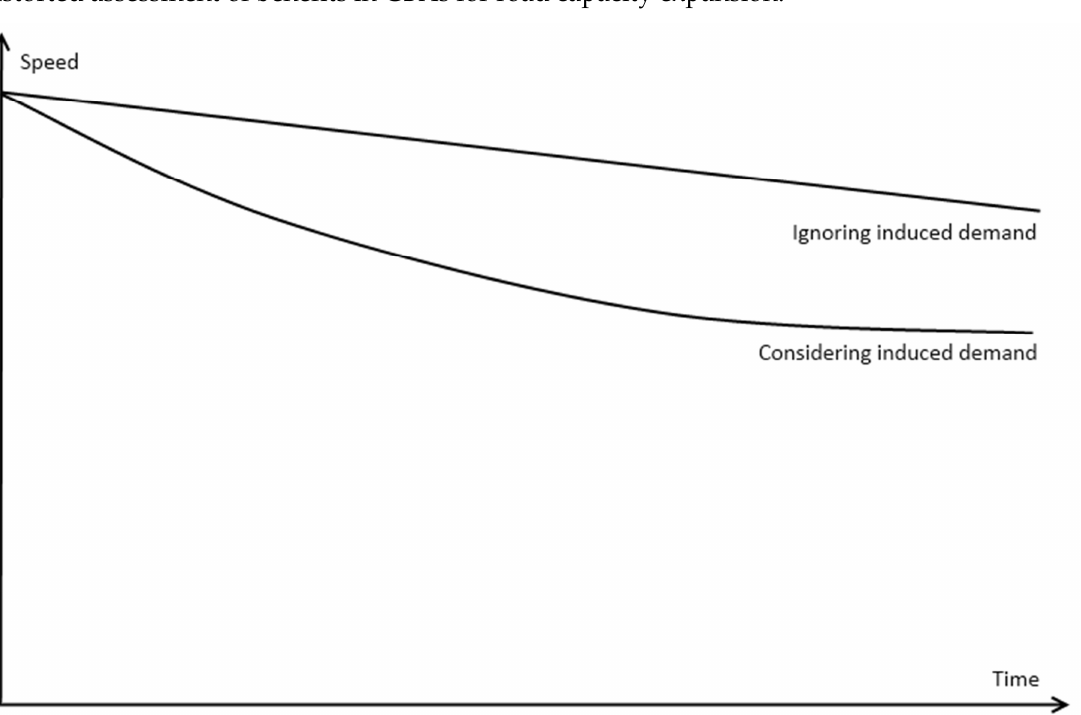
Figure 1. Projected average future traffic speeds, depending on whether or not induced traffic has been included in the forecasting model. Adapted from Litman (2011), p.